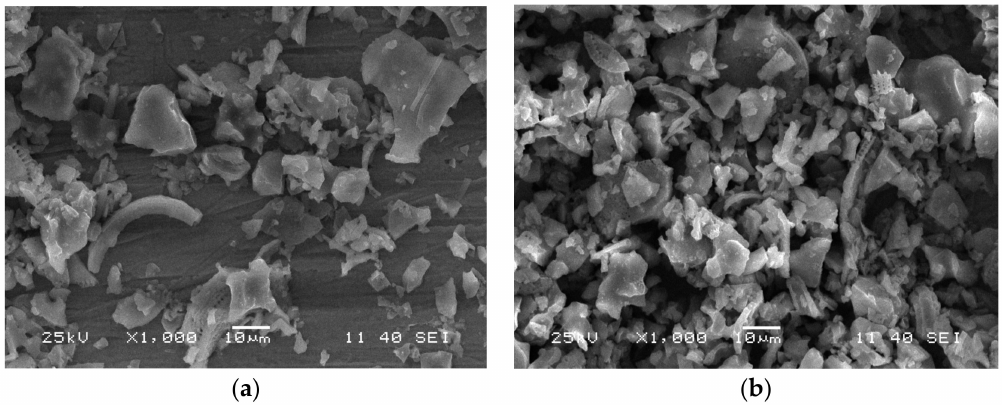
Figure 1. SEM of the ( a ) raw and ( b ) calcined 450 ◦ C diatomite.